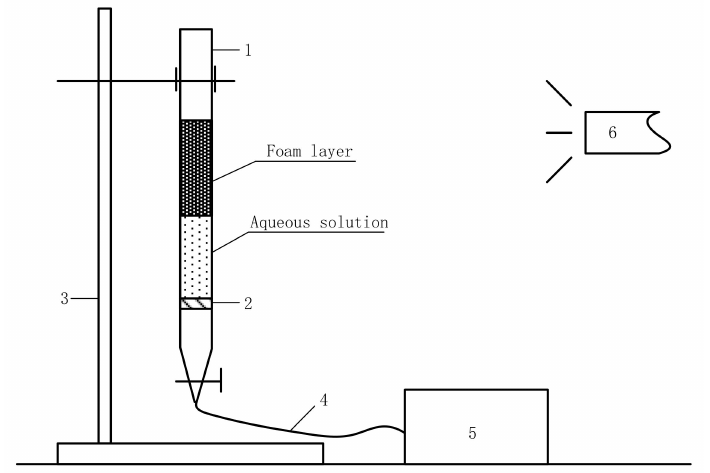
Figure 3. The simple device diagram of bubble property tests [30]: 1. Chromatography column; 2. Sand core; 3. Stent; 4. Hose; 5. Air pumps; 6.